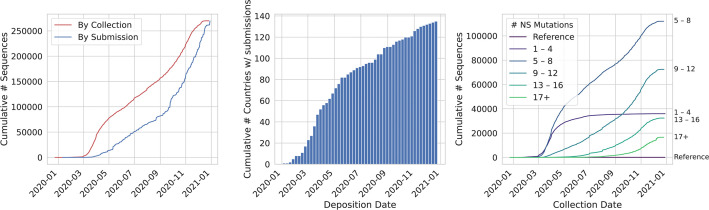
The number of global SARS-CoV-2 genome sequences and mutations is accumulating.Data shown as of January 2, 2021. (A) Sequence deposition in GISAID continues at a steady pace, albeit there is a lag between collection (red line) and submission date (blue line). The rate of sequence submission has grown to ~50,000,000 genomes per month. (B) One hundred and thirty-five countries have deposited SARS-CoV-2 genomes in GISAID. (C) The number of SARS-CoV-2 variants with more than four nonsynonymous (NS) mutations continues to increase.